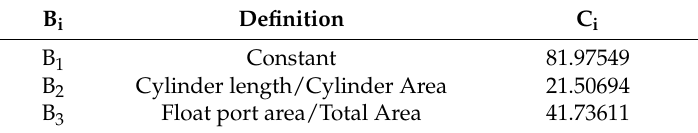
Table 3. List of basis functions of MARS model number two and their coefficients for feed with